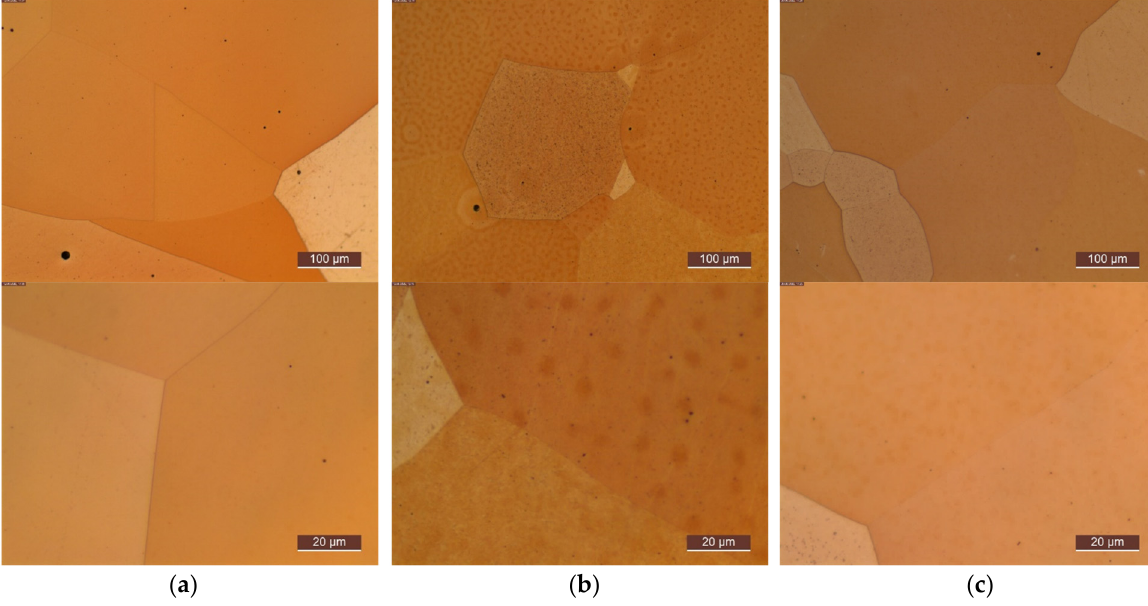
Figure A13. Microstructure evolution of Cu-OFE during DSC measurements in the optical microscope: specimen without cold rolling in DSC; ( a ) initial condition; ( b ) condition 1; ( c ) condition 2.